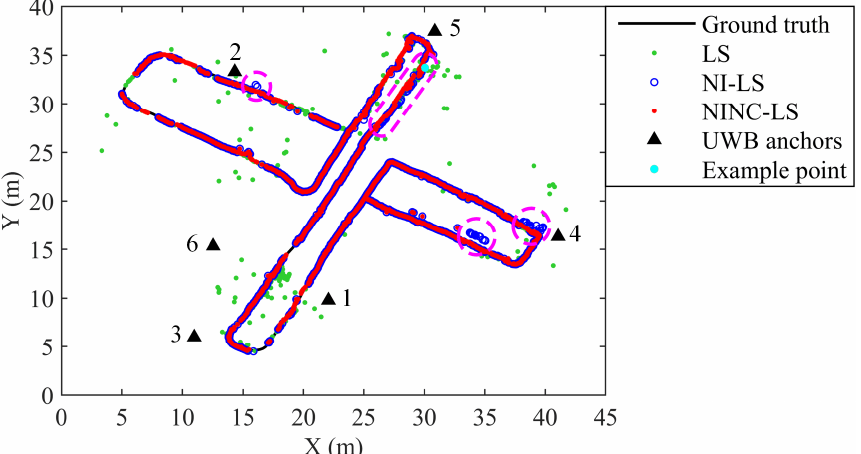
Figure 9. Trajectories of the three methods: LS (green), NI-LS (blue) and NINC-LS (red).